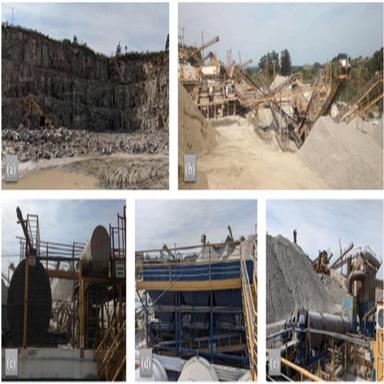
(a) rock panel; (b) crushing; (c) binder tanks; (d) silos for the asphalt plant; (e) continuous plant.